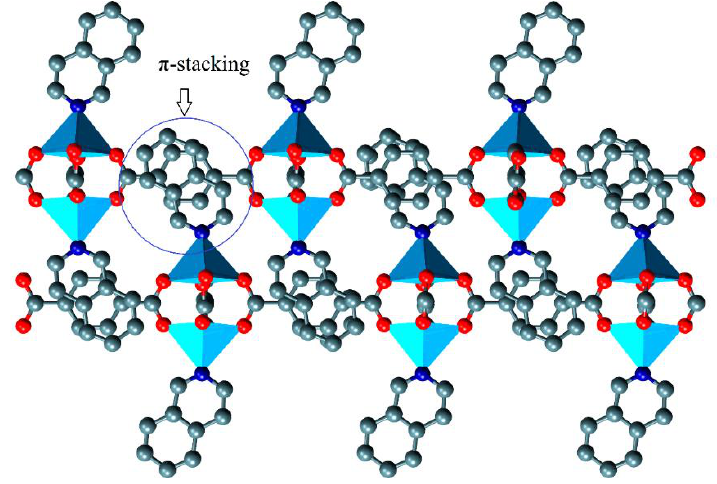
Figure 2. Dinuclear secondary building unit (SBU) and the 2D coordination array in 1 .